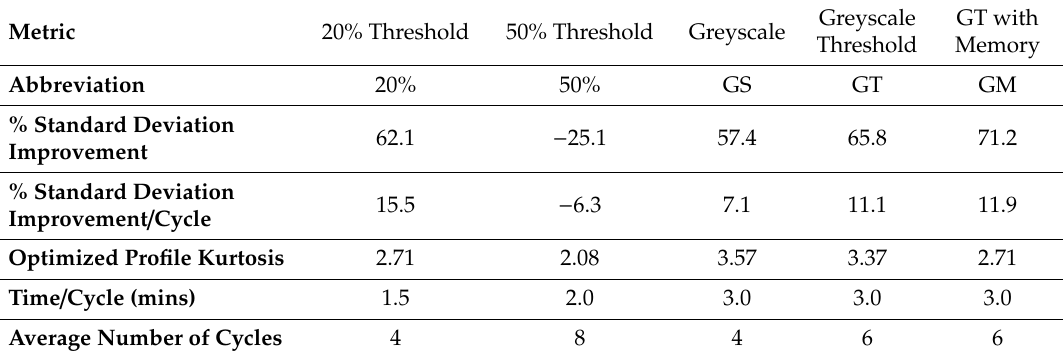
Table 4. The performance metrics of the various processing methods used to compare the total improvement of the temperature profile from the initial element to the optimized